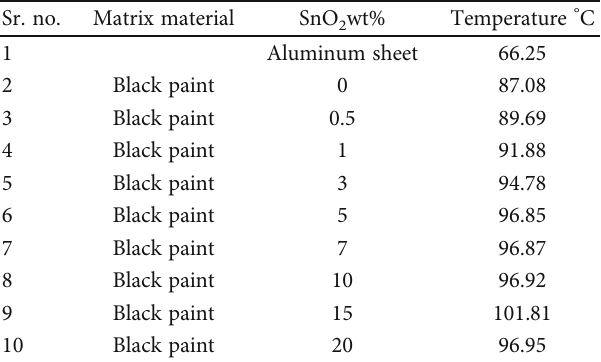
Table 2: Maximum temperature attained at 1000 W/m2 radiation level. Sr.